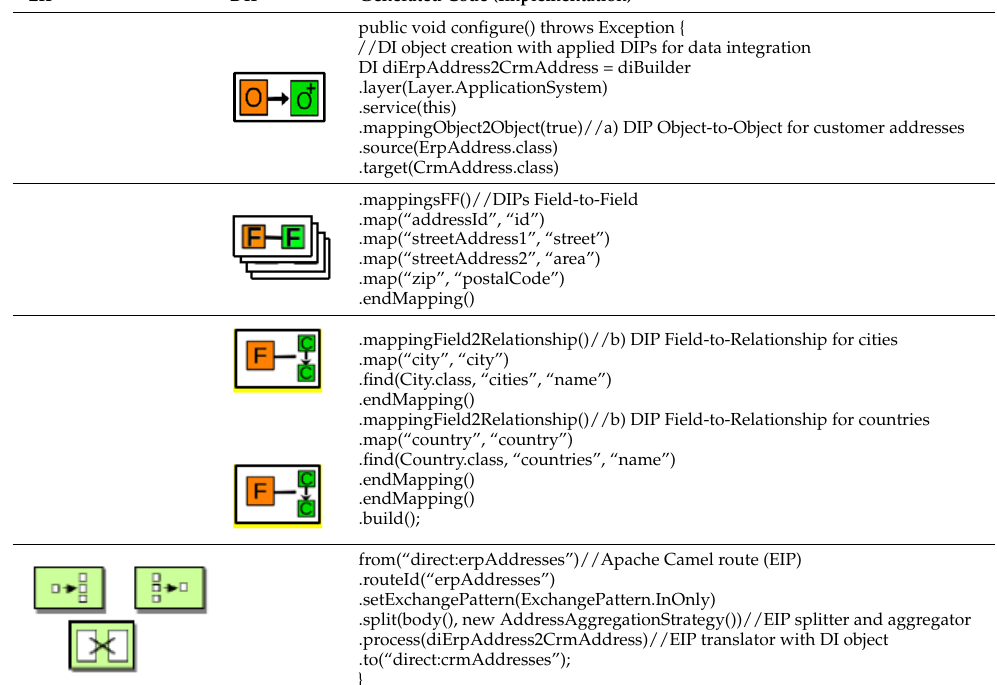
Table 6. Step 9: Application of EIPs and DIPs for the data integration tasks.